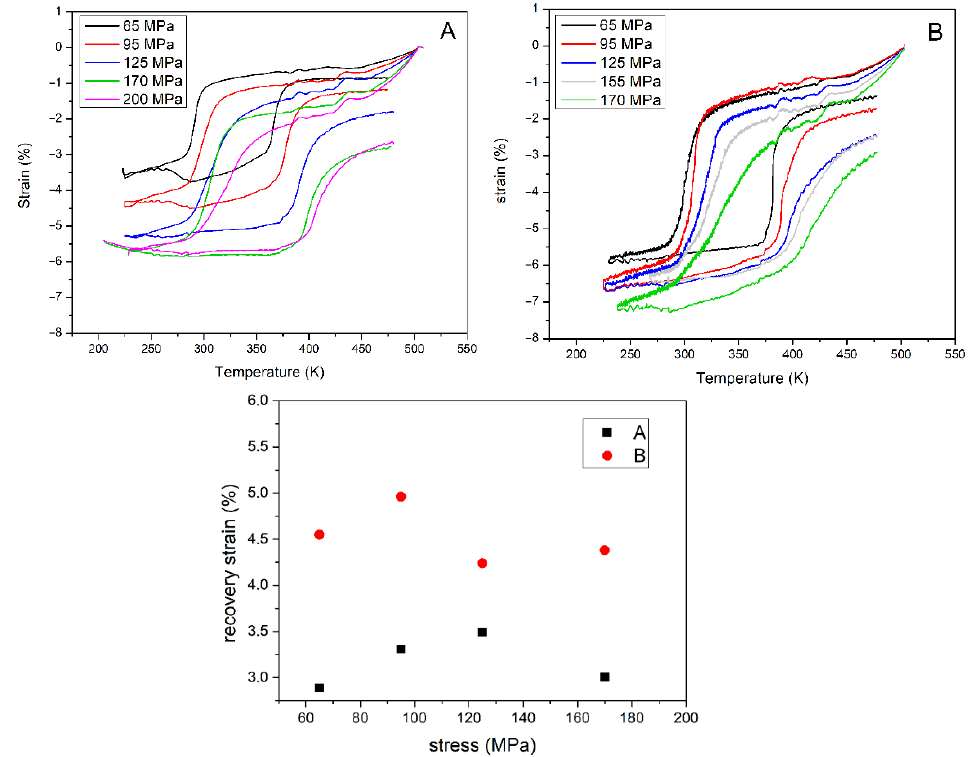
Figure 2. Strain recovery test vs. T under fixed stress and recovery strain vs. stress for samples A ( A ) and B ( B ).